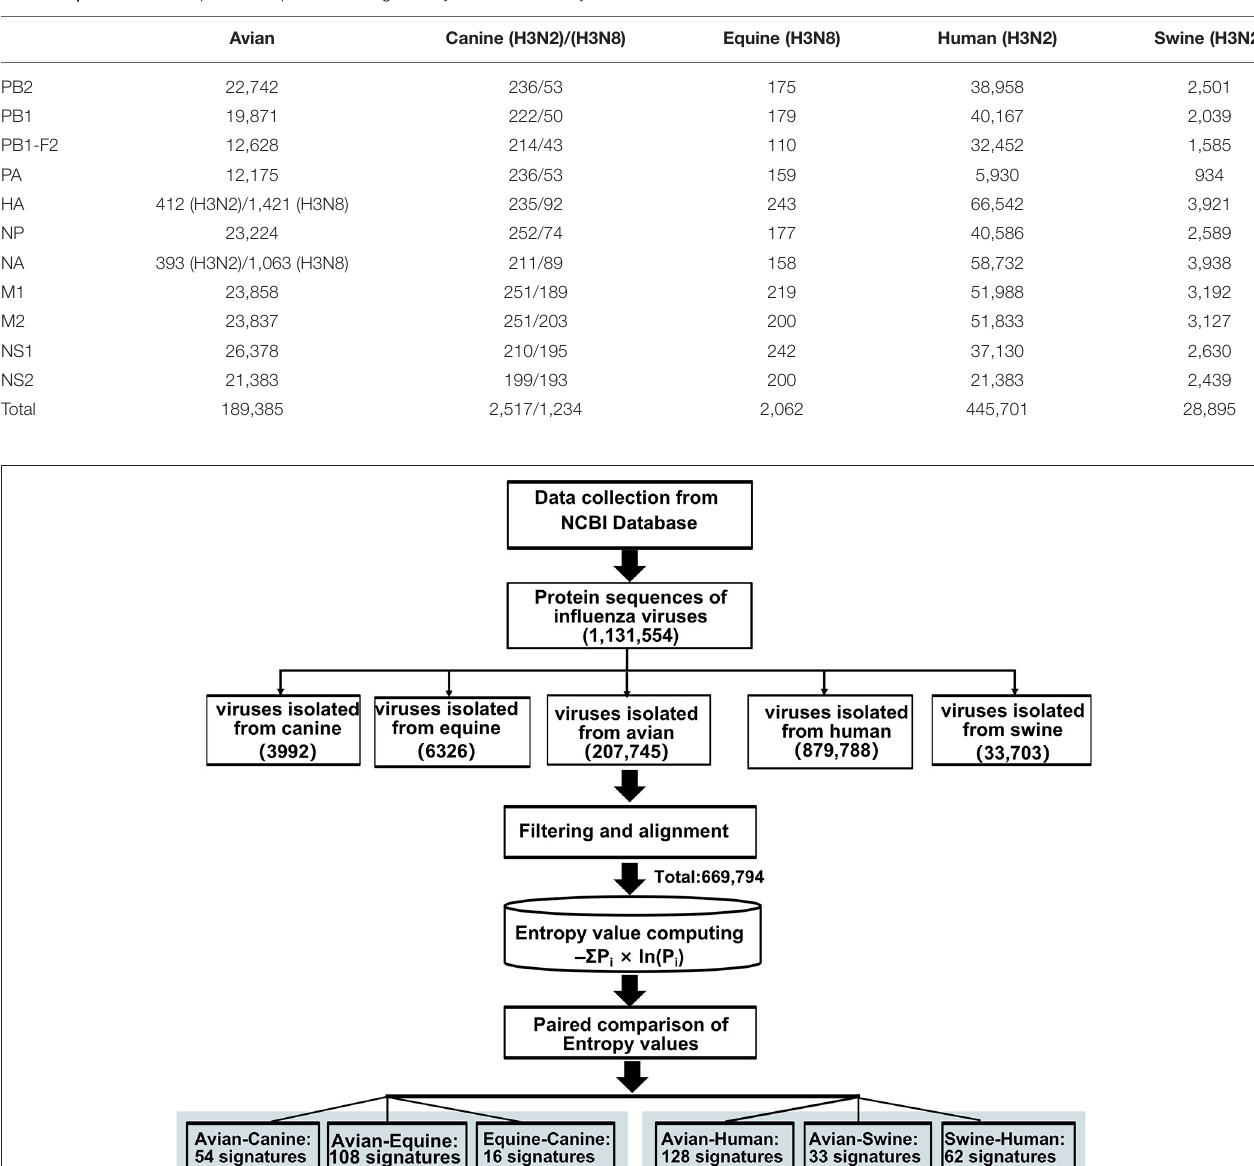
and H3N2 CIV sequences dataset. The accuracy reflected the efficacy of those positions to distinguish between avian-adaptive or canine-adaptive